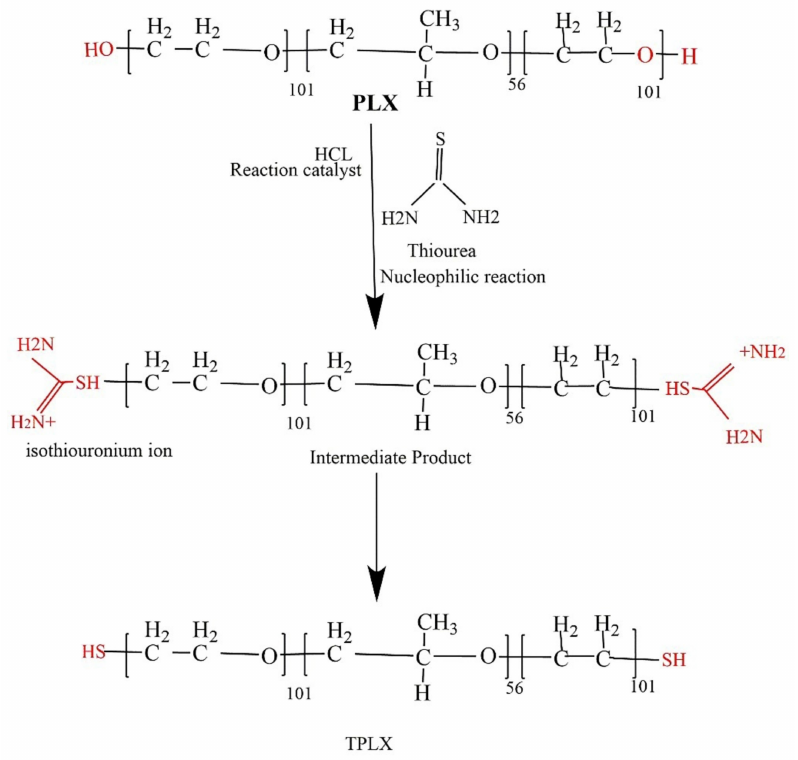
Figure 1. Schematic representation for the synthesis of TPLX using thiourea as the thiol